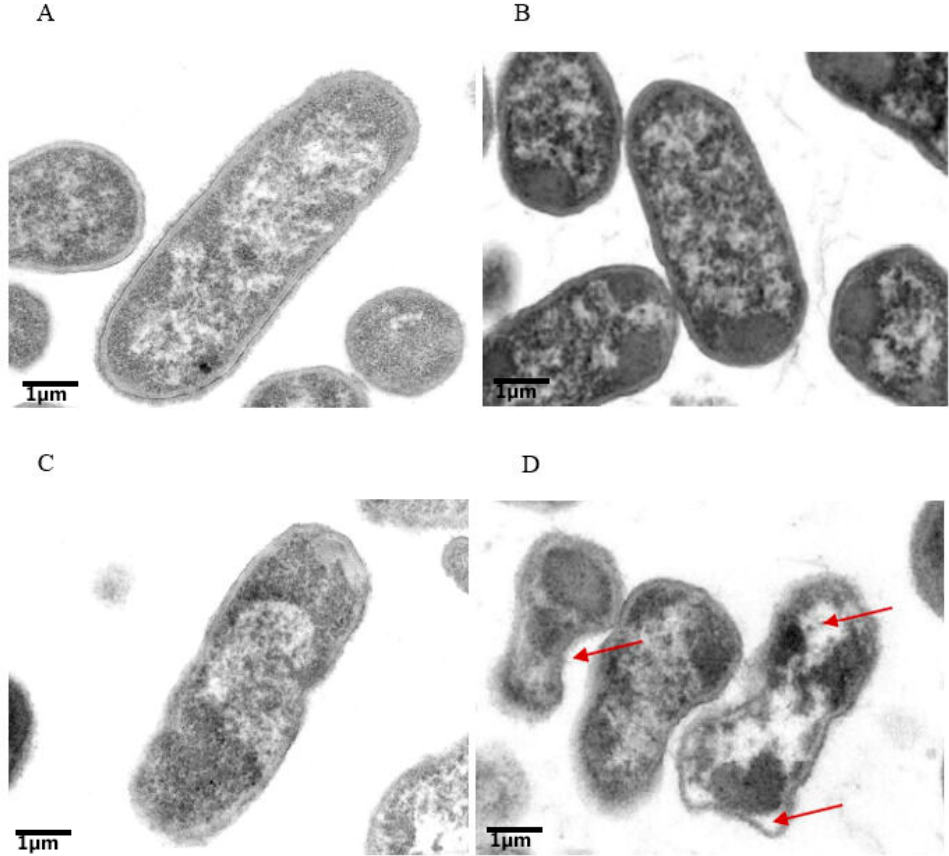
Figure 4. Colistin and tetrandrine in combination causes membrane damage and kills colistin-resistant E. coli . Transmission electron microscopic observation of ( A ) control untreated cells with intake cell morphology, ( B ) cells treated with colistin alone, ( C ) cells treated with tetrandrine, and ( D ) Cells treated with a combination of colistin and tetrandrine showing discontinuation of membranes and vacuoles moving out of cells.